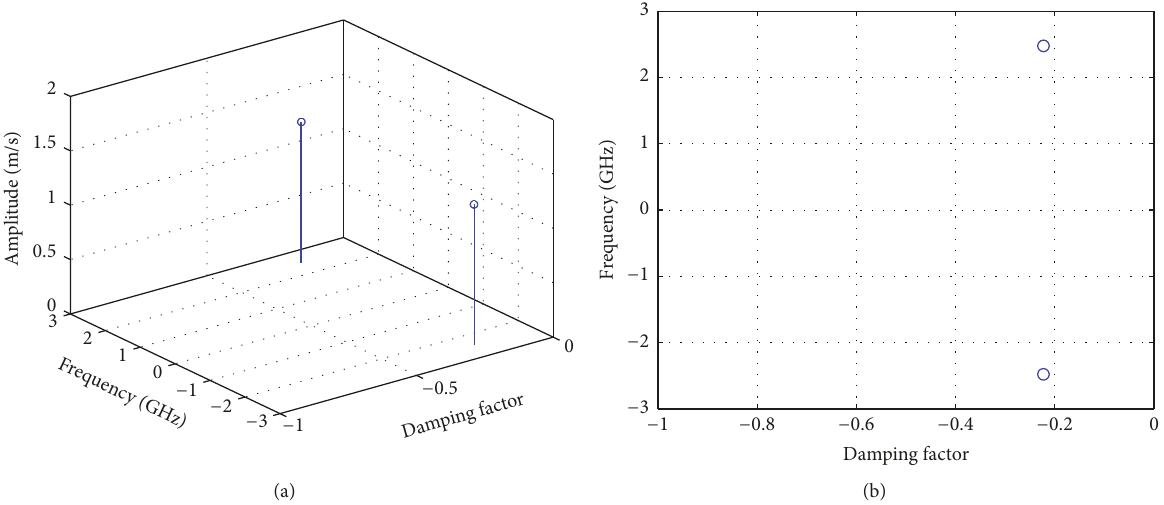
Figure 25: Using proposed enhanced MP method: (a) pole-residue relationship and (b) frequency versus damping factor. the resonant poles are appeared as nonphysical poles.